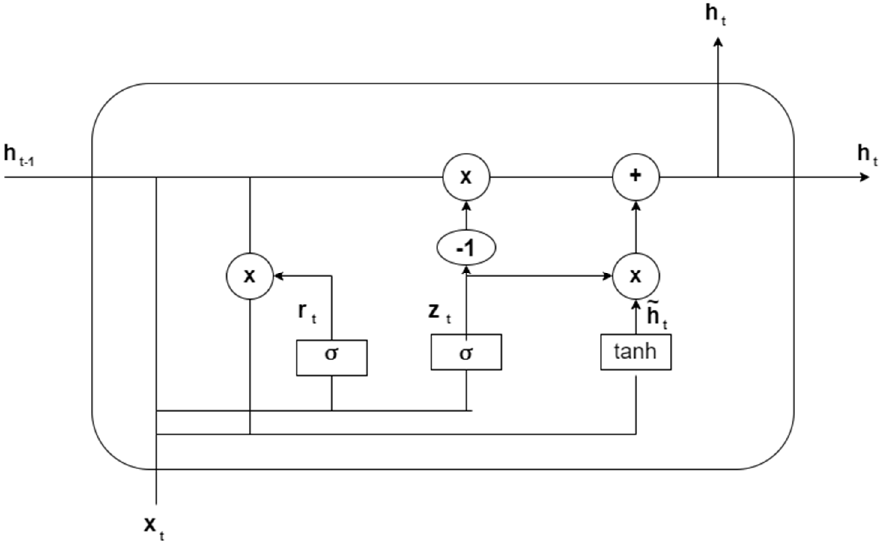
Figure 4. GRU model representation .